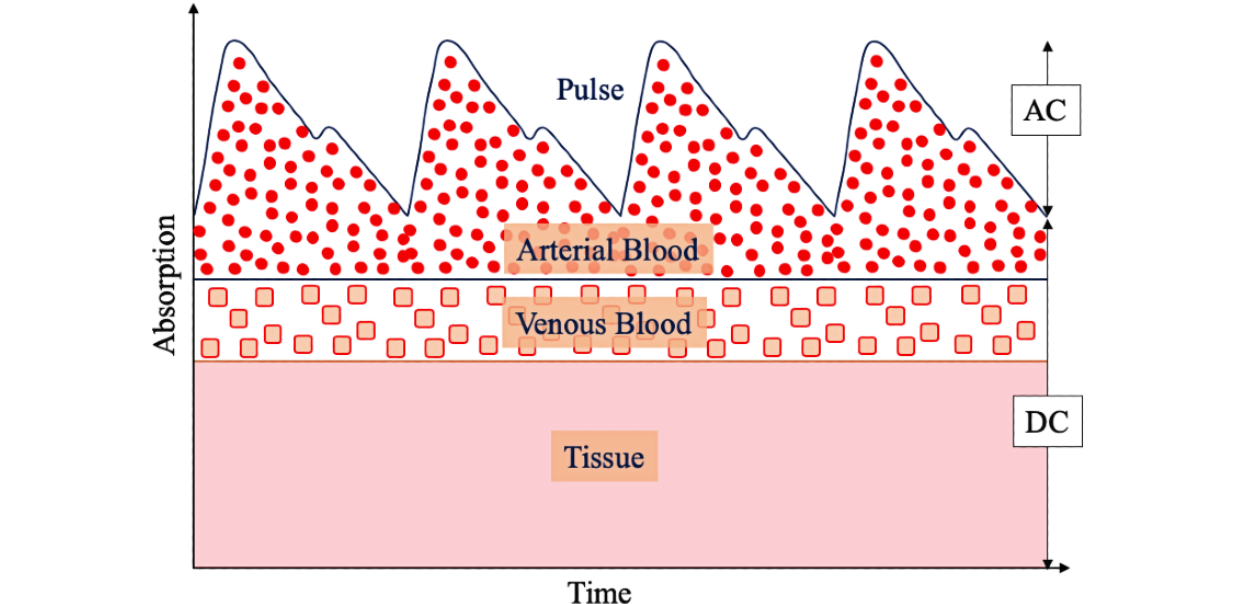
Figure 5. Light absorption changes for pulse, arterial, and venous blood, and living tissue. AC: alternating current; DC: direct current.